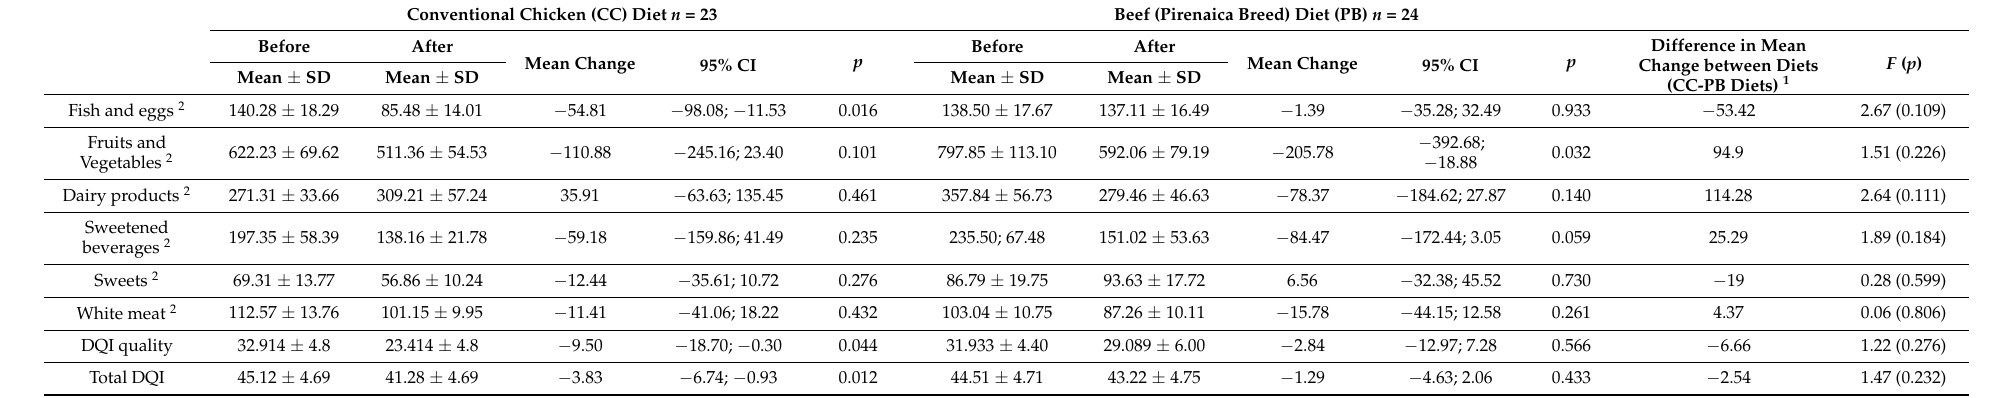
Table 2. Differences in some food groups, DQI quality component and total DQI after Conventional Chicken versus beef (Pirenaica breed) diets during period 1